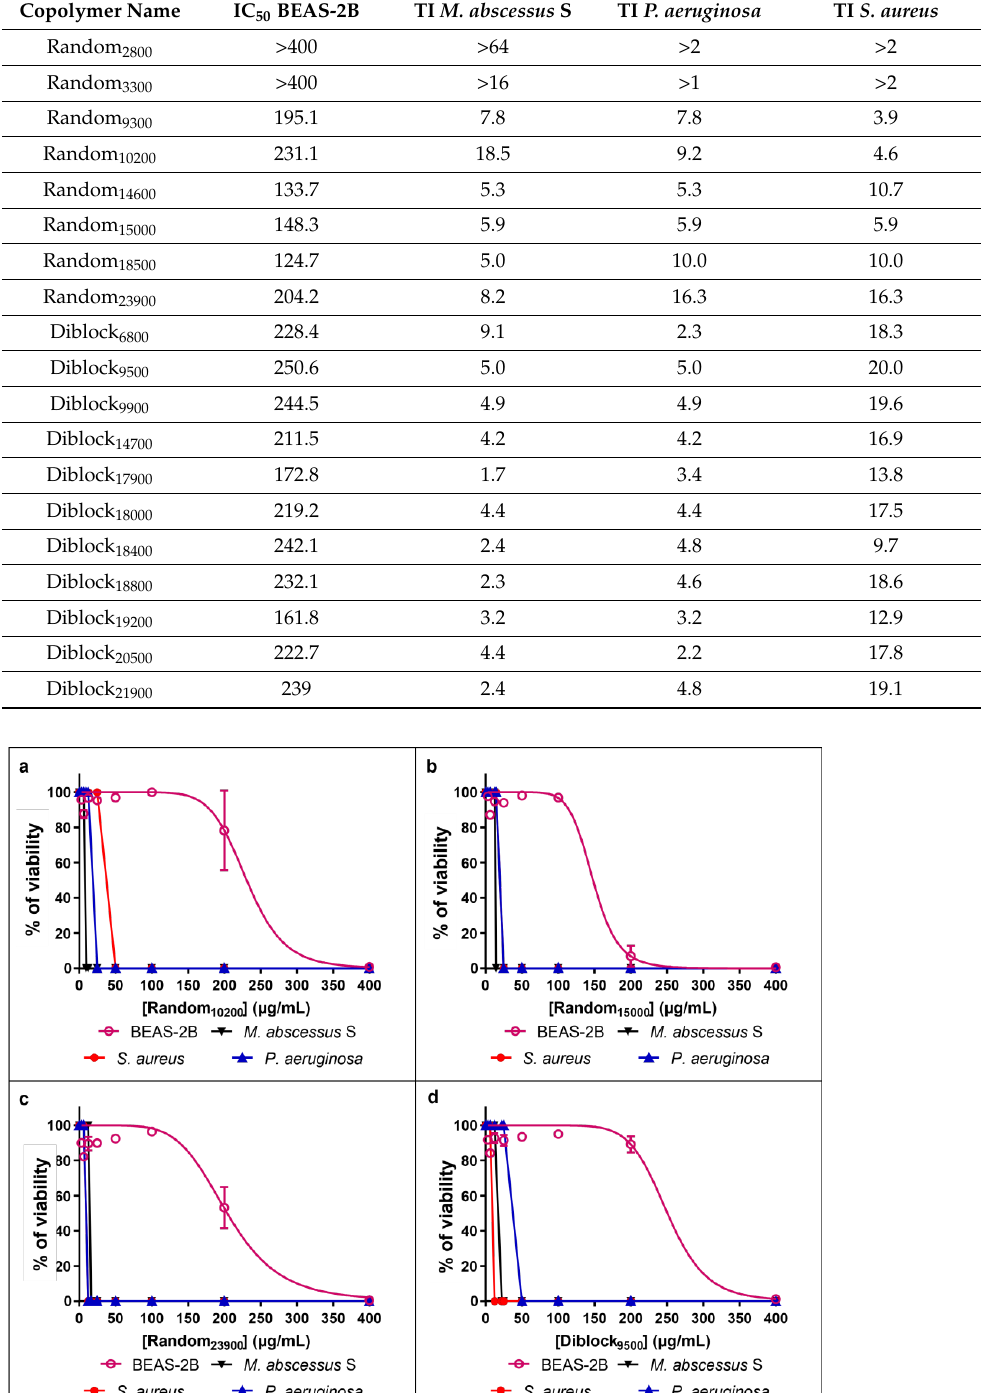
Table 3. Evaluation of the innocuity of Random and Diblock copolymers. IC 50 values of Random and Diblock copolymers (expressed in µ g/mL) on BEAS-2B viability were calculated using data from Figure 2a. Therapeutic Index (TI) was calculated by dividing the IC 50 of the copolymer by their MIC value for each bacterial strain. Copolymer Name IC 50 BEAS-2B TI M. abscessus S TI P. aeruginosa TI S. aureus